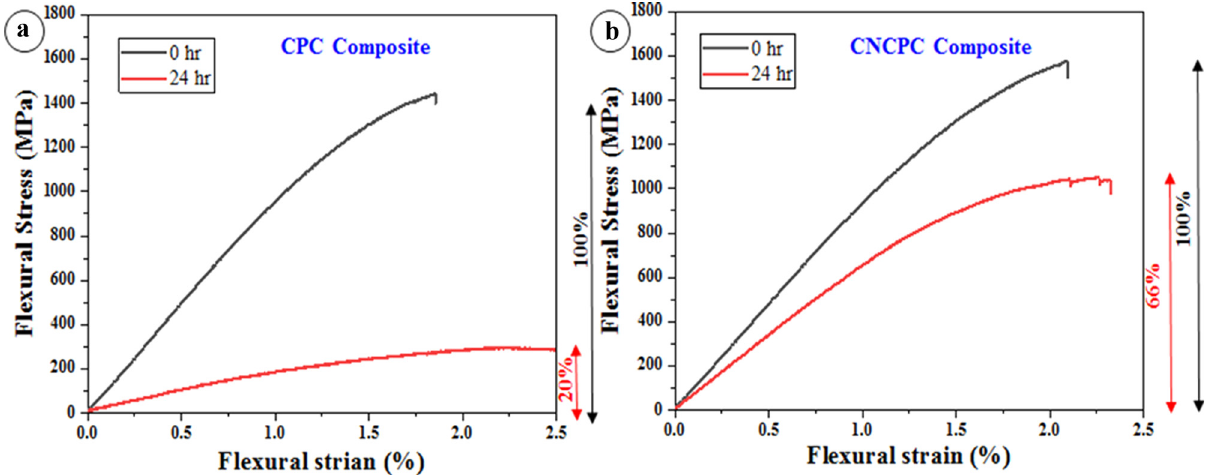
Figure 5: Flexural stress – strain curves of ( a ) CPC and ( b ) CNCPC composites at 24 h